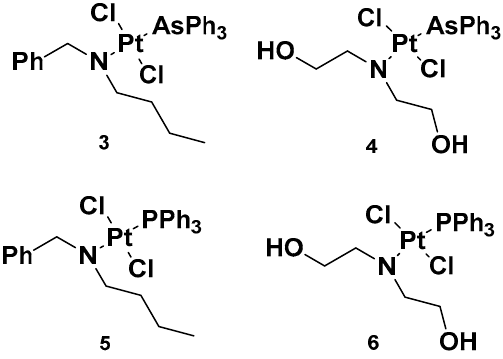
Figure 4. Complexes 3 and 4 and previously synthesized analogs 5 and 6